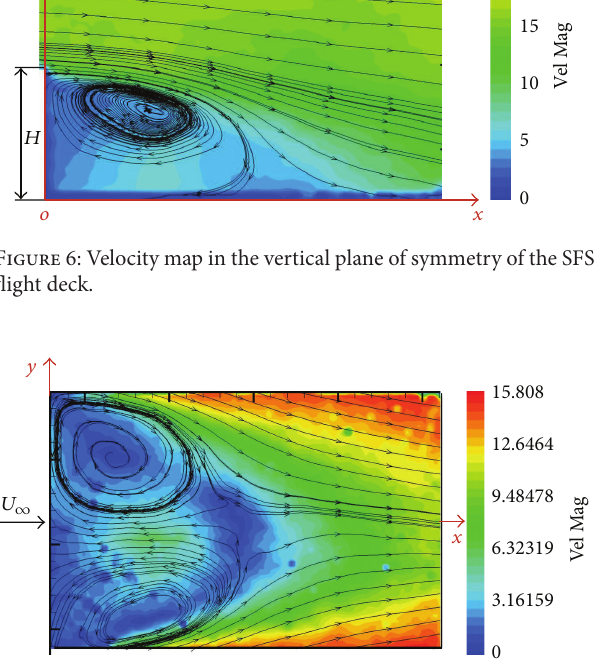
Figure 7: Velocity map in the horizontal plane of the SFS flight deck ( 𝑧/𝐻 = 0.5 ).